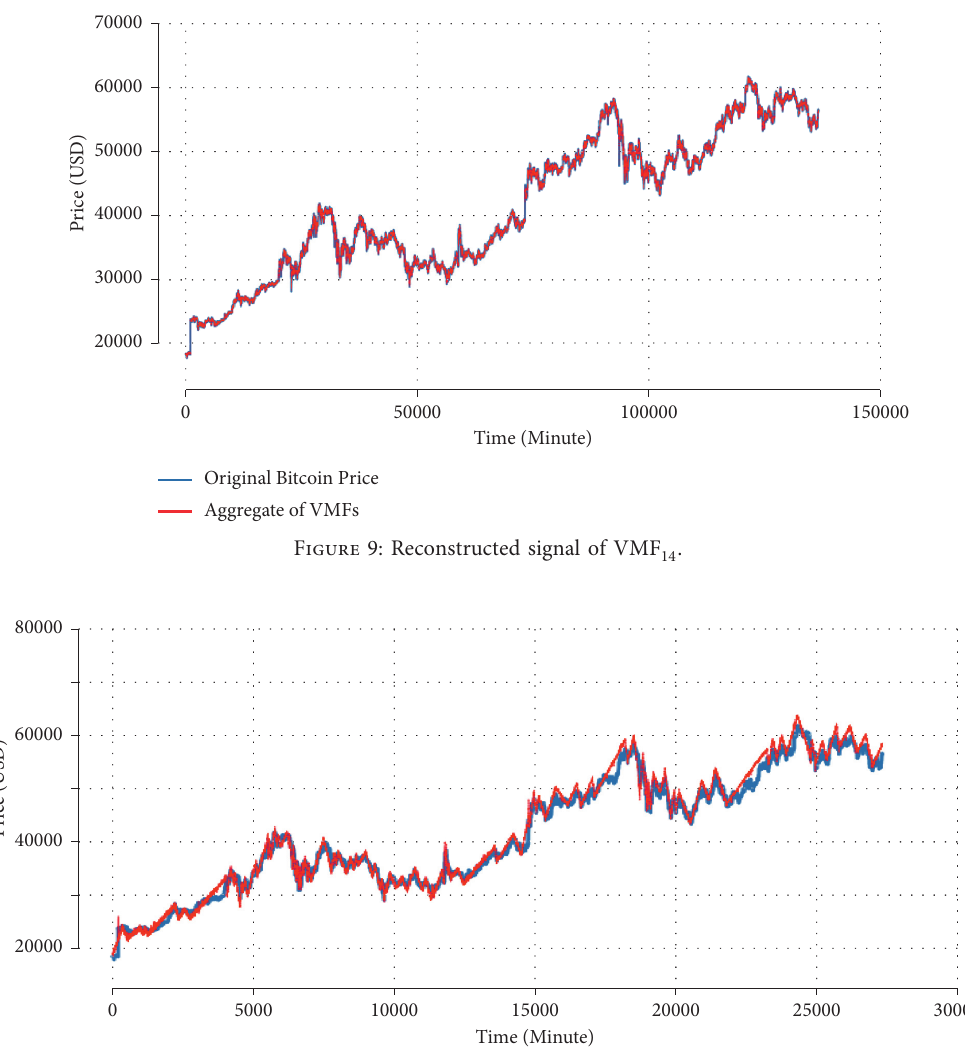
Figure 10: Prediction results via SVR-TI